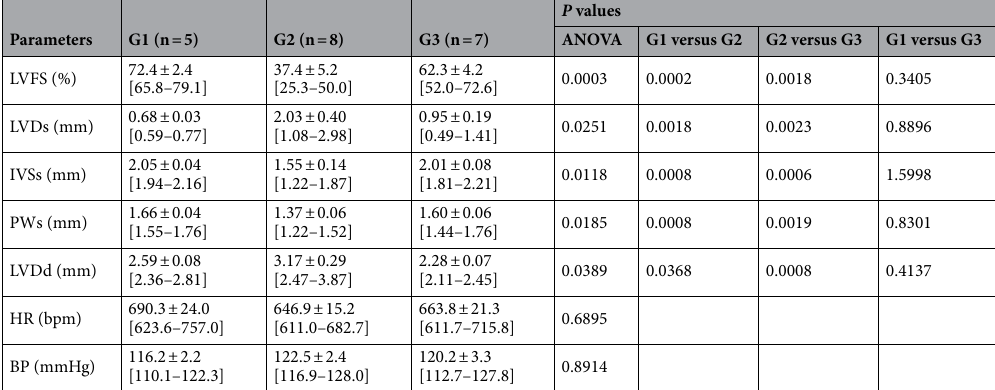
Table 3. Echocardiographic data on day 56 in experimental autoimmune myocarditis (EAM) mice. Data are mean ± SEM [95% confidence interval]. Echocardiographic findings on day 56 in non-EAM mice treated daily with vehicle only (G1: n = 5) or in EAM mice treated daily with vehicle (G2: n = 8) or selective prostaglandin E2 receptor 4 agonist (ONO-0260164) (G3: n = 7) from day 14 to day 56. P values were calculated with 2-way ANOVA followed by the Bonferroni-Dunn post hoc testing method. LVFS left ventricular fractional shortening, LVDs LV end-systolic dimension, IVSs interventricular septum systolic thickness, PWs LV posterior wall systolic thickness, LVDd LV end-diastolic dimension, HR heart rate, BP systolic blood pressure.